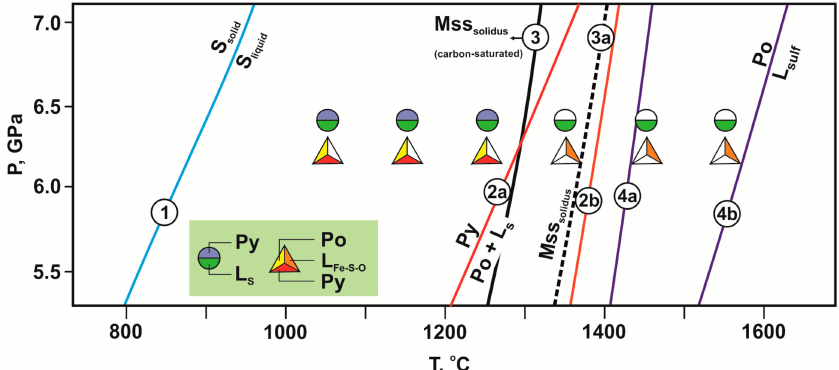
Figure 4. P-T diagram with parameters and results of experiments in the olivine-ankerite-sulfur (circles) and olivine-ankerite-pyrite (triangles) systems. Symbols are vertically displaced for clarity. Experimentally determined curves: 1—melting of sulfur [43]; 2a, 4a—decomposition of pyrite [44,45]; 2b, 4b—melting of pyrrhotite [44,45]; 3, 3a—solidi of monosulfide solid solution